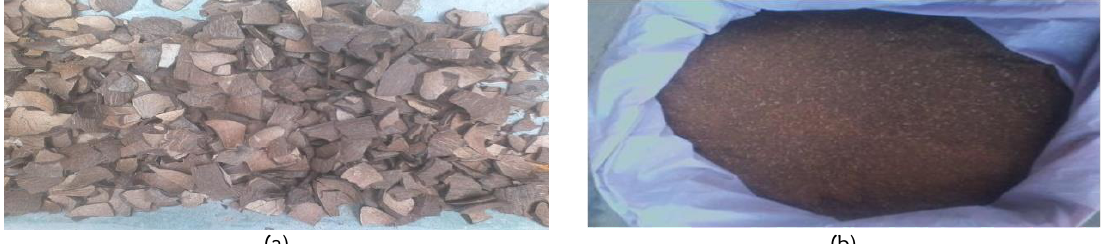
Figure 1: (a) Crushed coconut shells and (b) sieved coconut shell powder